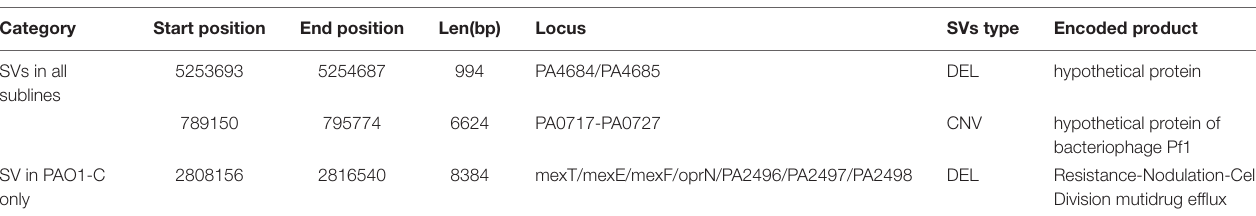
TABLE 3 | List of structure variation in each